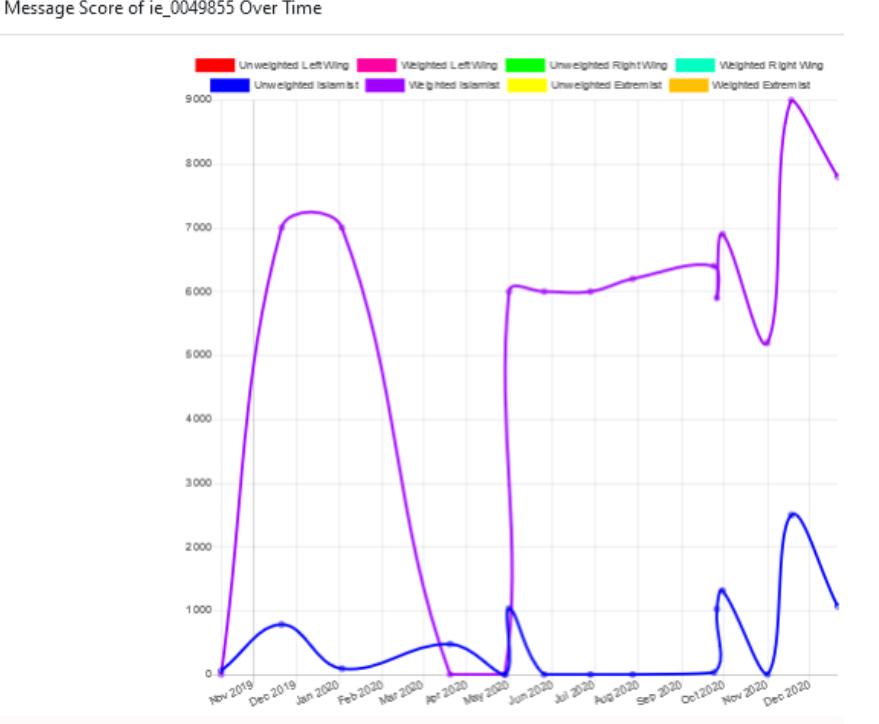
Figure 12. Visualisation of radicalisation scores over time. This plot shows the weighted and unweighted radicalisation scores change over time for the person ie_0049855, who was introduced in Section 4.1. The scoring schemes were introduced in Section